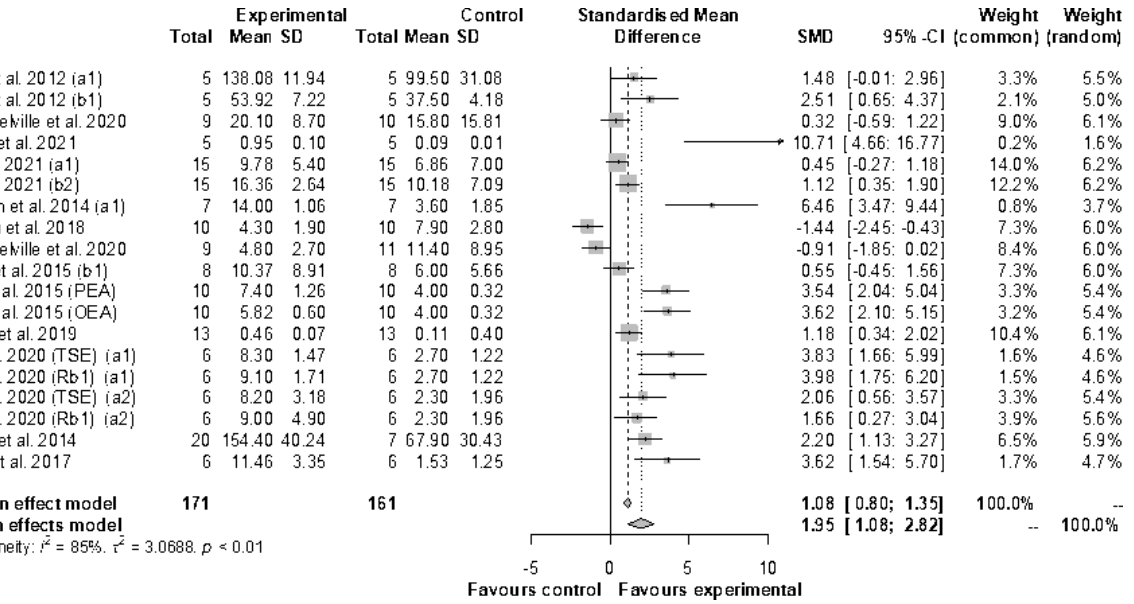
Figure 6. Forest plot showing the nutraceutical effects of reducing mechanical allodynia and hyperalgesia by measuring the withdrawal threshold in the injured paw. SD, standard deviation; SMD, standardized mean differences; CI, confidence interval.